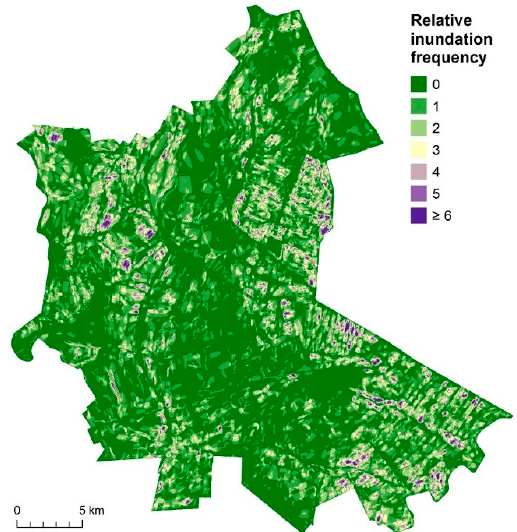
Figure 2. Map of temporally aggregated legacy information on inland excess water (IEW) inundation frequency. The values do not show real frequencies, they can be considered as an indicator (Number of inundation events occurred within the period from where observations are available).